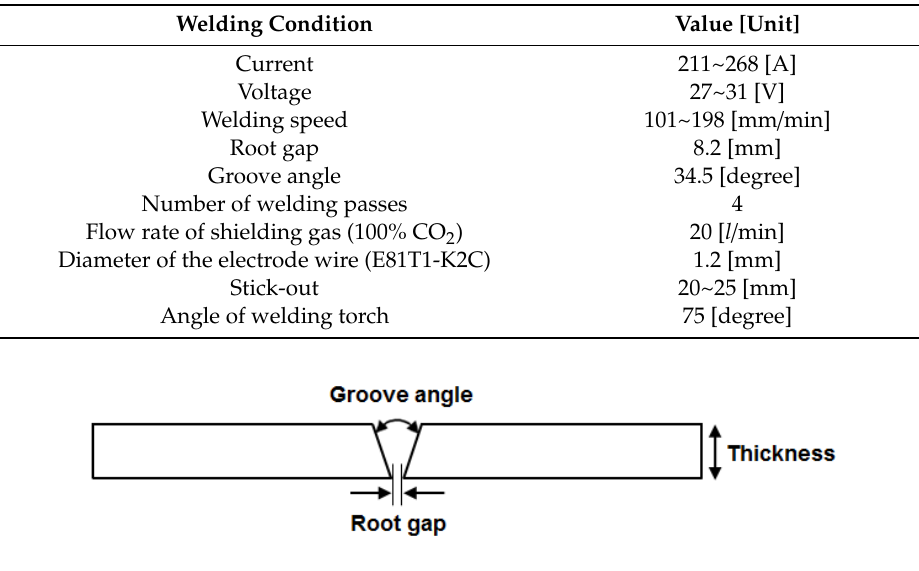
Figure 5. Definition of root gap and groove angle.